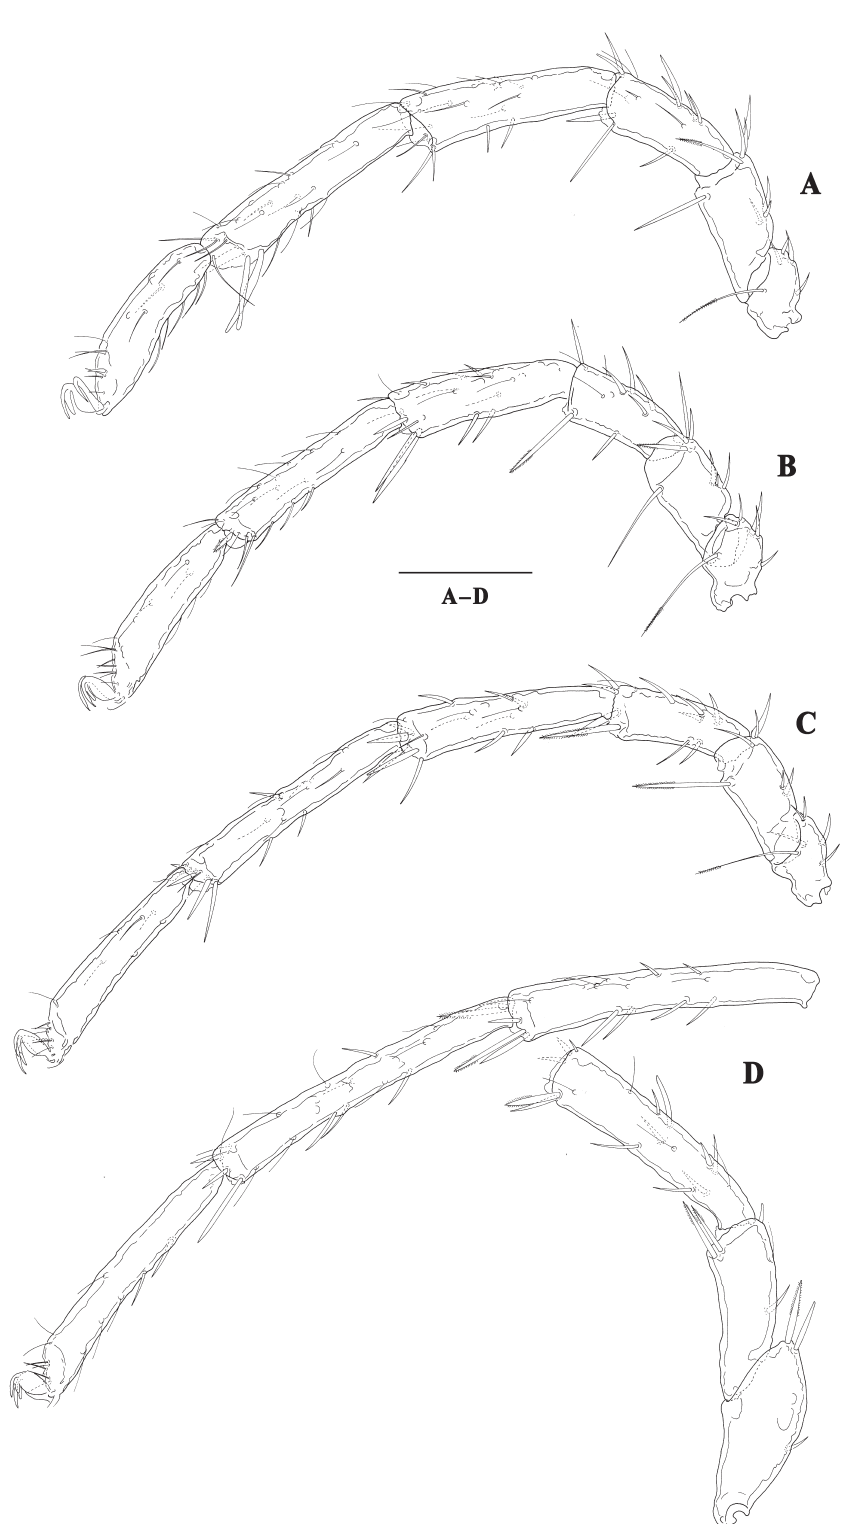
Fig. 13. Atractides ( Atractides ) xianmiensis Zhang, Li & Guo sp. nov., holotype, ♂ (GUGC, Slide No. QH-HY-2020072910). A–D . I-L–IV-L. Scale bar = 100